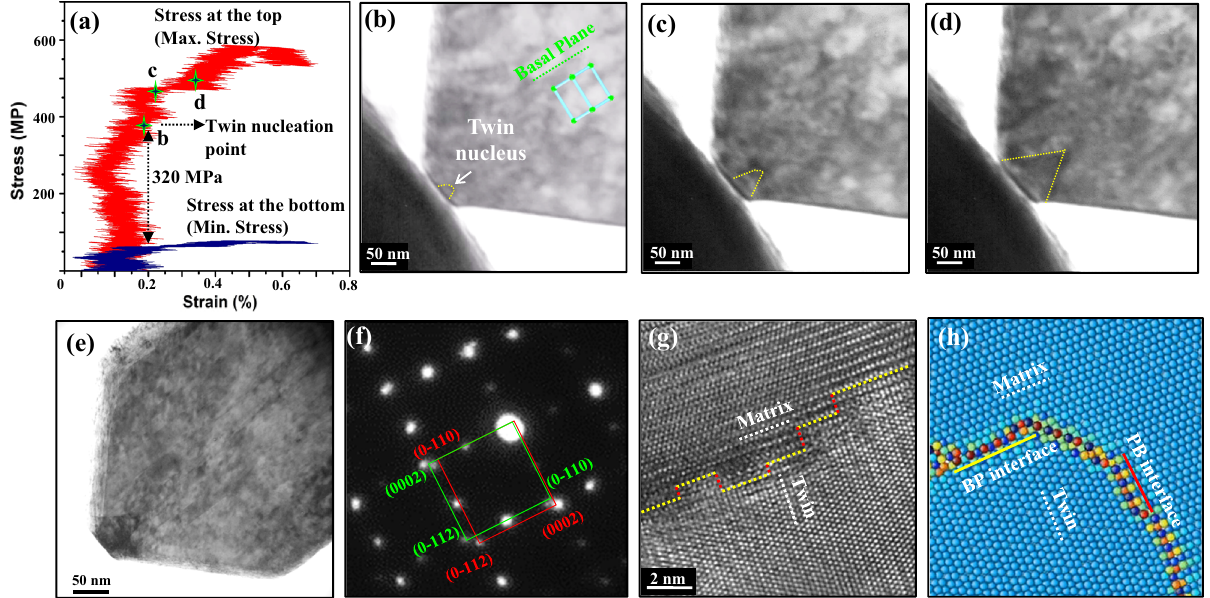
Fig. 3 Twinning events in the truncated wedge-shaped Mg pillar with the 100nm top in which there is a high stress difference. a Corresponding compression curves of the pillar. The max. stress curve was calculated by the ratios of compression loading to the cross section of the pillar top. The min. stress curve was calculated by the ratios of compression loading to the cross section of the pillar bottom. The value of 320 MPa shows the stress gap at the twin nucleation point b. b – d Bright- fi eld TEM snap-shots shows twin nucleation from the pillar top. The dashed yellow lines in b – d indicate the locations of twin boundaries. e Bright- fi eld TEM image shows the morphology of the twin nucleus. f A selected area diffraction pattern demonstrates the orientation relationship between twin and matrix. The diffraction pattern is associated with a semi-coherent twin embryo structure where the coherency stress has been relaxed during sample thinning for HRTEM observation. g HRTEM images of twin boundaries shows the basal/prismatic terraced boundary. The yellow dashed lines indicate the basal-prismatic (BP) interfaces, and the red lines indicate the prismatic-basal (PB) interfaces. h Simulated atomic twin boundary structure with BP or PB interfaces. Atoms are color coded according to their excess energy, with the lowest energy atoms appearing blue, while the highest energy atoms appear red. The white dashed lines in g , h indicate the basal